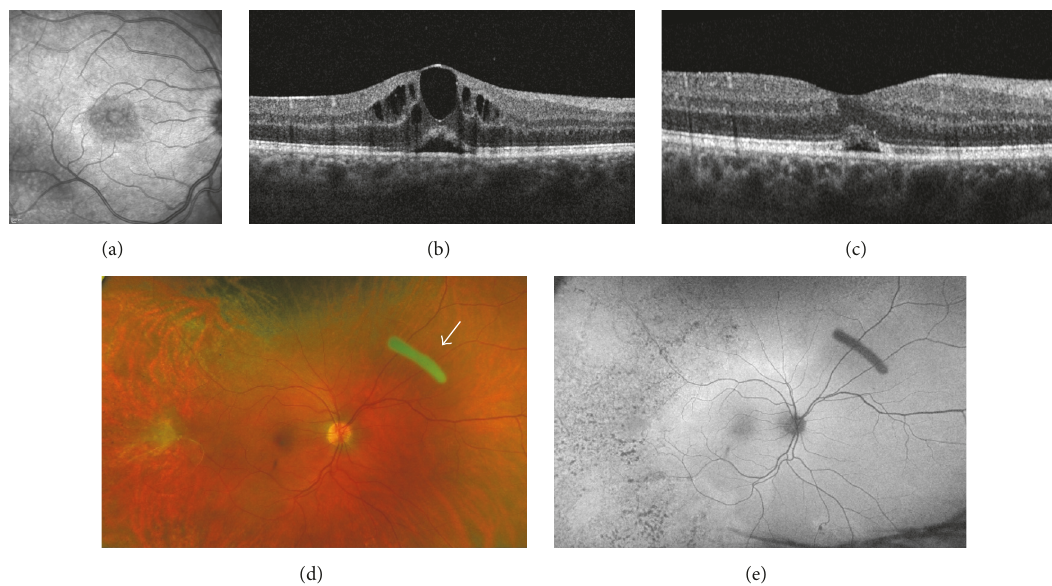
Figure 1: (a) Infrared fundus photo of the macula showing cystoid macular edema (CME); (b) optical coherence tomography (OCT) of the macula showing CME prior to treatment; (c) macular OCT showing resolution of CME with small amount of subretinal fluid; (d) color fundus photo after resolution of retinitis with white arrow pointing to the dexamethasone intravitreal implant; (e) autofluorescence fundus photo demonstrating temporal hypofluorescent changes that represent scarring following syphilitic retinitis.